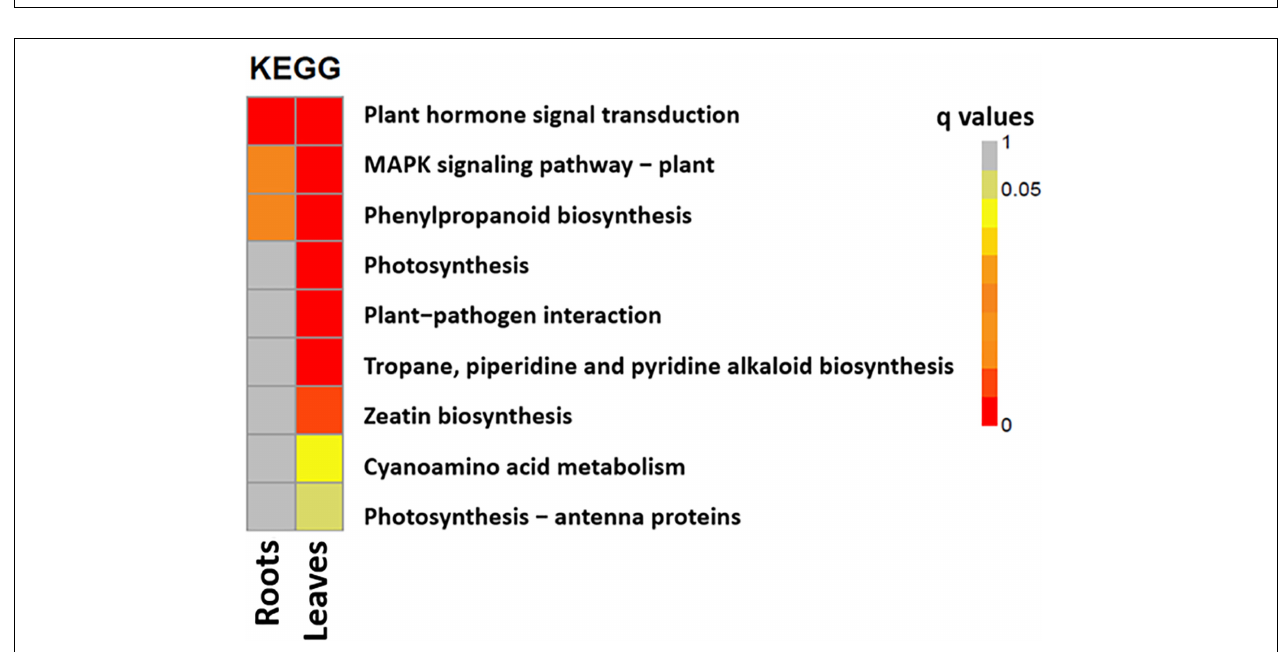
FIGURE 5 | The most enriched KEGG pathways in the roots (T1_C1) and leaves (T2_C2) of S. argel plants are exposed to salt stress.